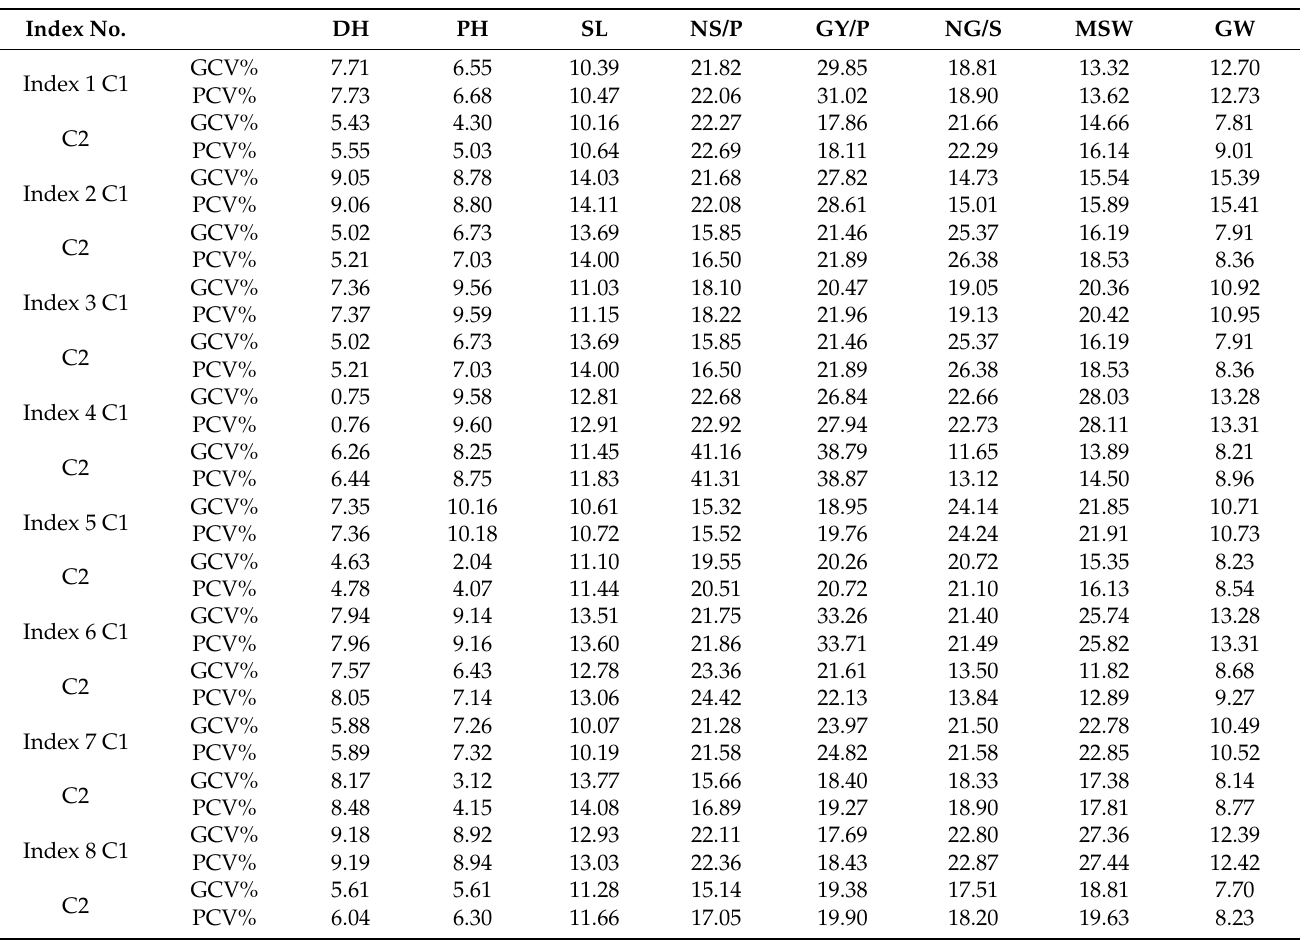
Table 3. Genotypic (GCV%) and phenotypic (PCV%) coefficients of variability in the two cycles of